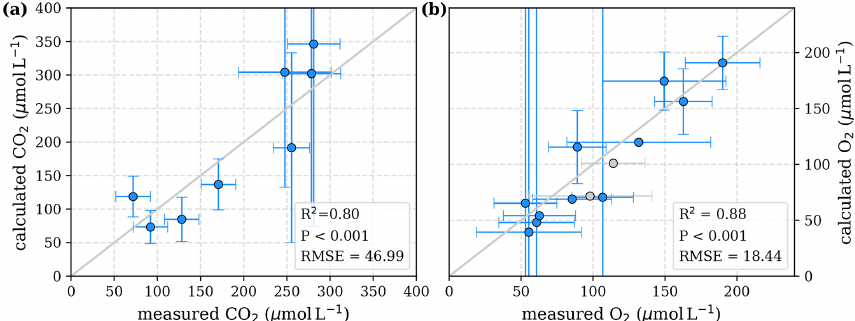
Figure 3. Correlation between measured and calculated concentrations of (a) CO 2 and (b) O 2 . Grey lines indicate the 1 : 1 line. Calculations were performed based on the equations in Table 1 which represent linear pH limitation of decomposition rates. Each data point represents one river. Grey data points are excluded from the correlation since the data for these rivers are based on fewer than three campaigns within the same season. This includes the Simunjan campaigns with high carbon concentrations, which are excluded here due to figure scaling and further discussed in Appendix D5.